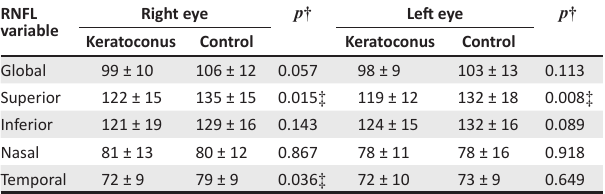
FIGURE 2: A ganglion cell complex map showing the average total, superior and inferior ganglion cell complex thicknesses. TABLE 1: Means and standard deviations for age and ocular characteristics of the keratoconus ( n = 28) and control ( n = 28) groups. Age and ocular characteristics